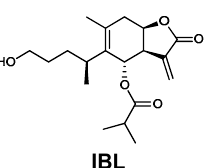
Figure 1. Chemical structure of 6- O -isobutyrylbritannilactone (IBL) isolated from the flower of I. britannica .